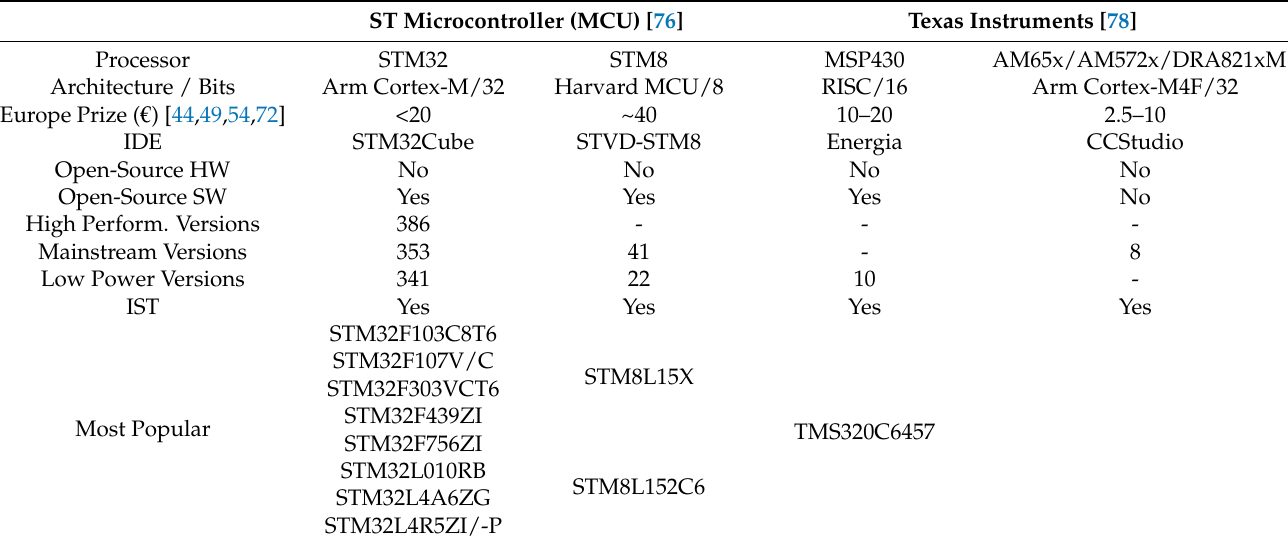
Table 1. Main proprietary SBMs in the market.